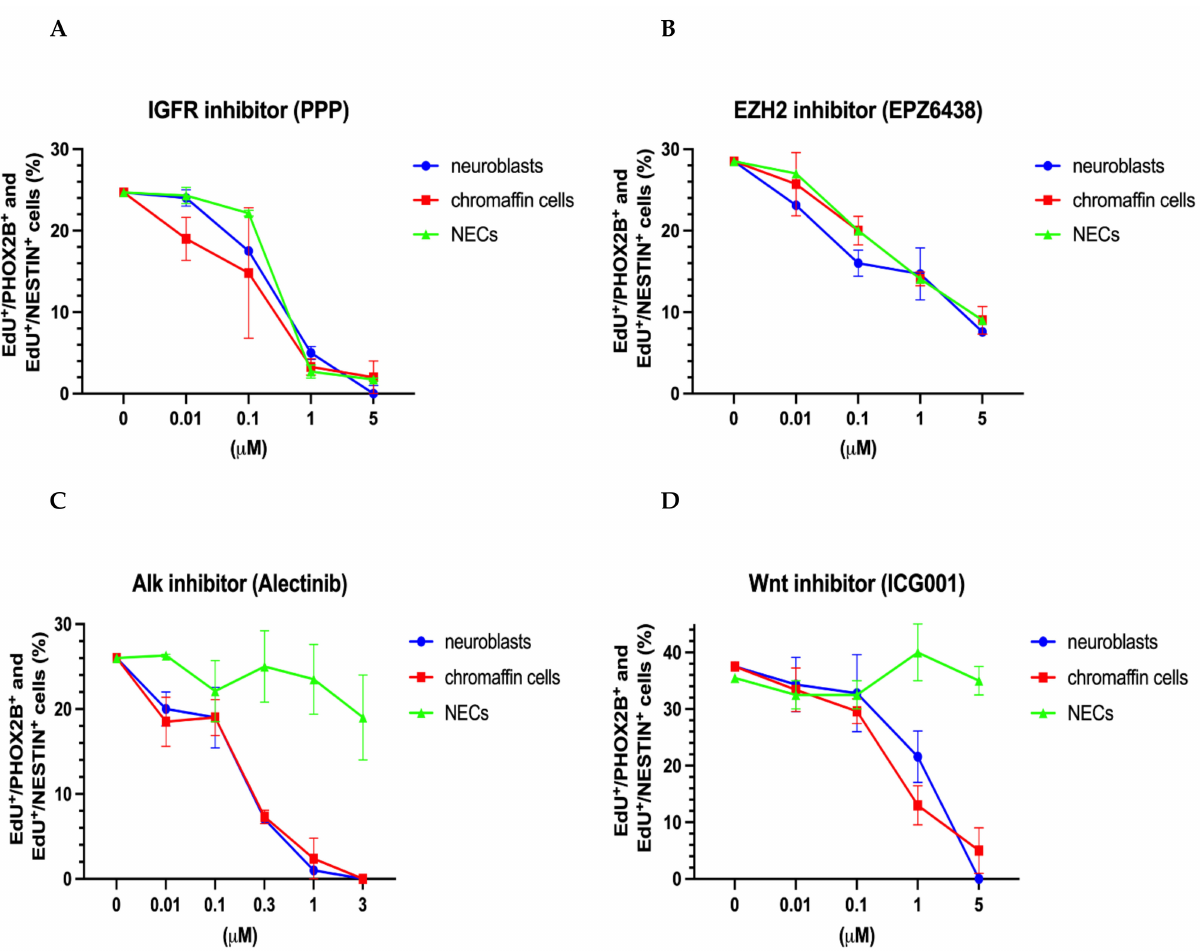
Figure 6. Effect of IGF, EZH2, ALK, and WNT inhibitors on the proliferation of chromaffin cells, neuroblasts, and NESTIN-expressing cells (NECs). Dose–response curves are shown for IGFR inhibitor (PPP) ( A ), EZH2 inhibitor (EPZ6438) ( B ), Alk inhibitor (Alectinib), ( C ) and Wnt inhibitor (ICG001) ( D ). Data represent the mean ± s. e. m. of at least three independent